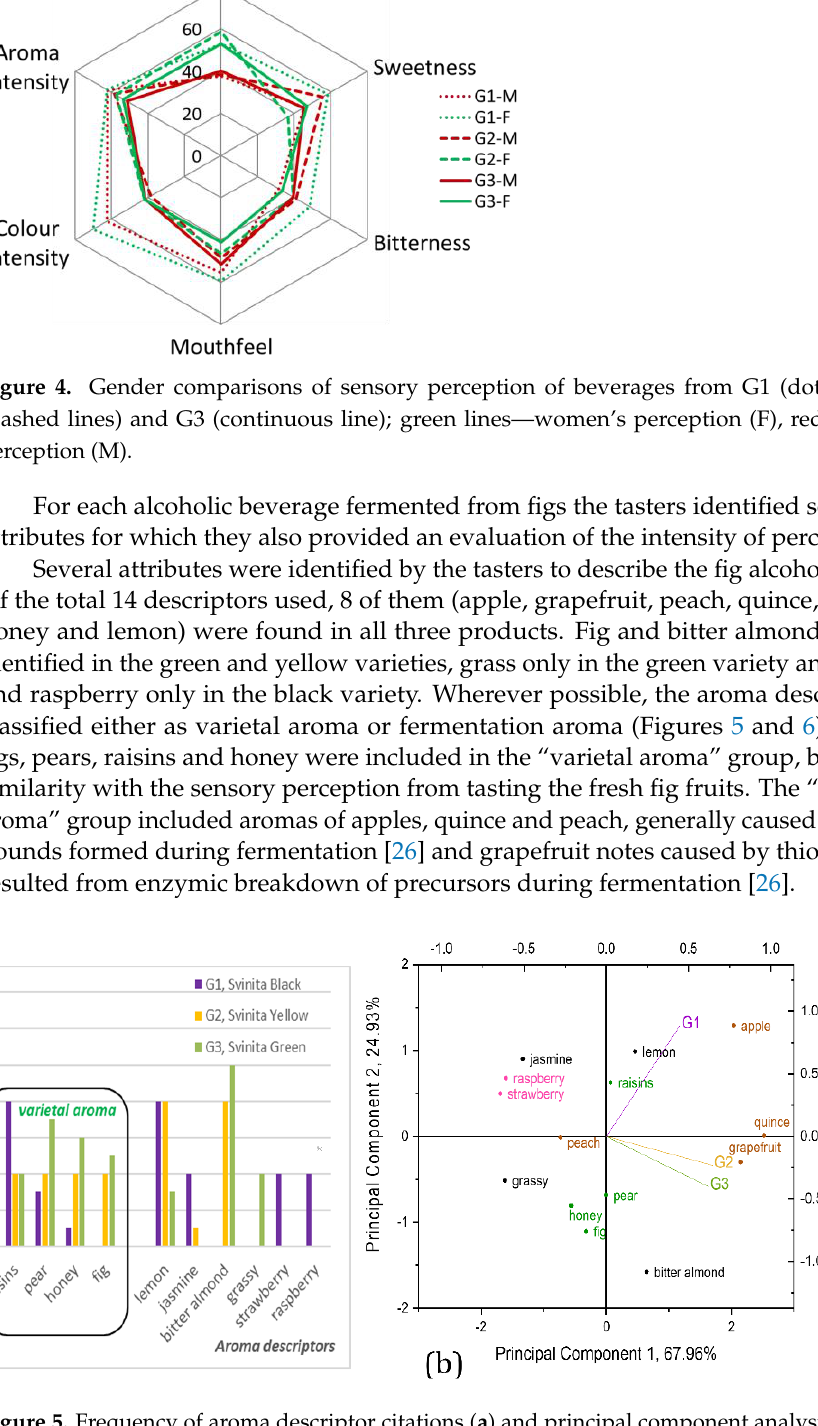
Figure 6. Intensity of the perceived aroma attribute ( a ) and principal component analysis based on the perceived intensity of aroma attribute ( b ) for the beverages from fig varieties G1 – G3. In accordance with the frequency of each descriptor cited by the tasters, in Figure 5a all 14 aroma attributes are presented for all the three fig varieties. The principal compo- nent analysis in Figure 5b presents the correlation of the aroma descriptors with the overall aroma perception of each beverage obtained from the three fig varieties, G1 – G3. The fine balance between these aroma attributes also has a big influence on the overall flavour, therefore, the intensity with which each aroma is perceived is determi- nant. The principal component analysis in Figure 6 shows the intensities perceived for the main aroma attributes (Figure 6a) and the correlation of these aroma types with the fig variety from which the alcoholic beverage is obtained (Figure 6b). Based on the perception intensity of the main varietal and fermentation aroma at- tributes, the aroma profiles of the obtained beverages are illustrated in Figure 7a. To have an overall description of the alcoholic beverages obtained from the three fig varieties, the total sensory profiles containing both the main sensory parameters and the aroma parameters are illustrated in Figure 7b.